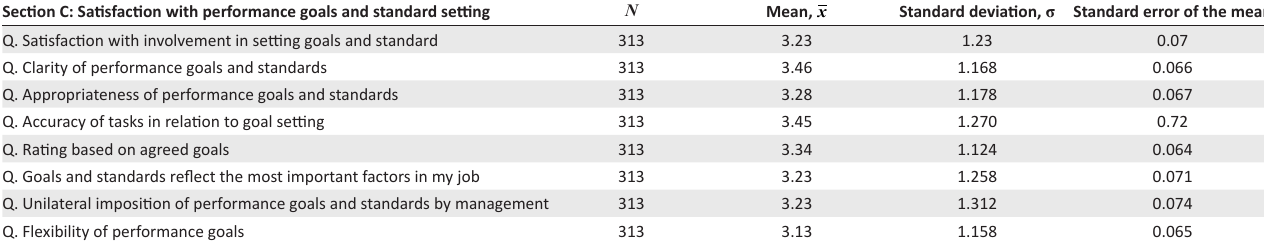
TABLE 3: Results of one-sample t -test statistics for Section C of the measuring instrument. Section C: Satisfaction with performance goals and standard setting N Mean, x Q. Satisfaction with involvement in setting goals and